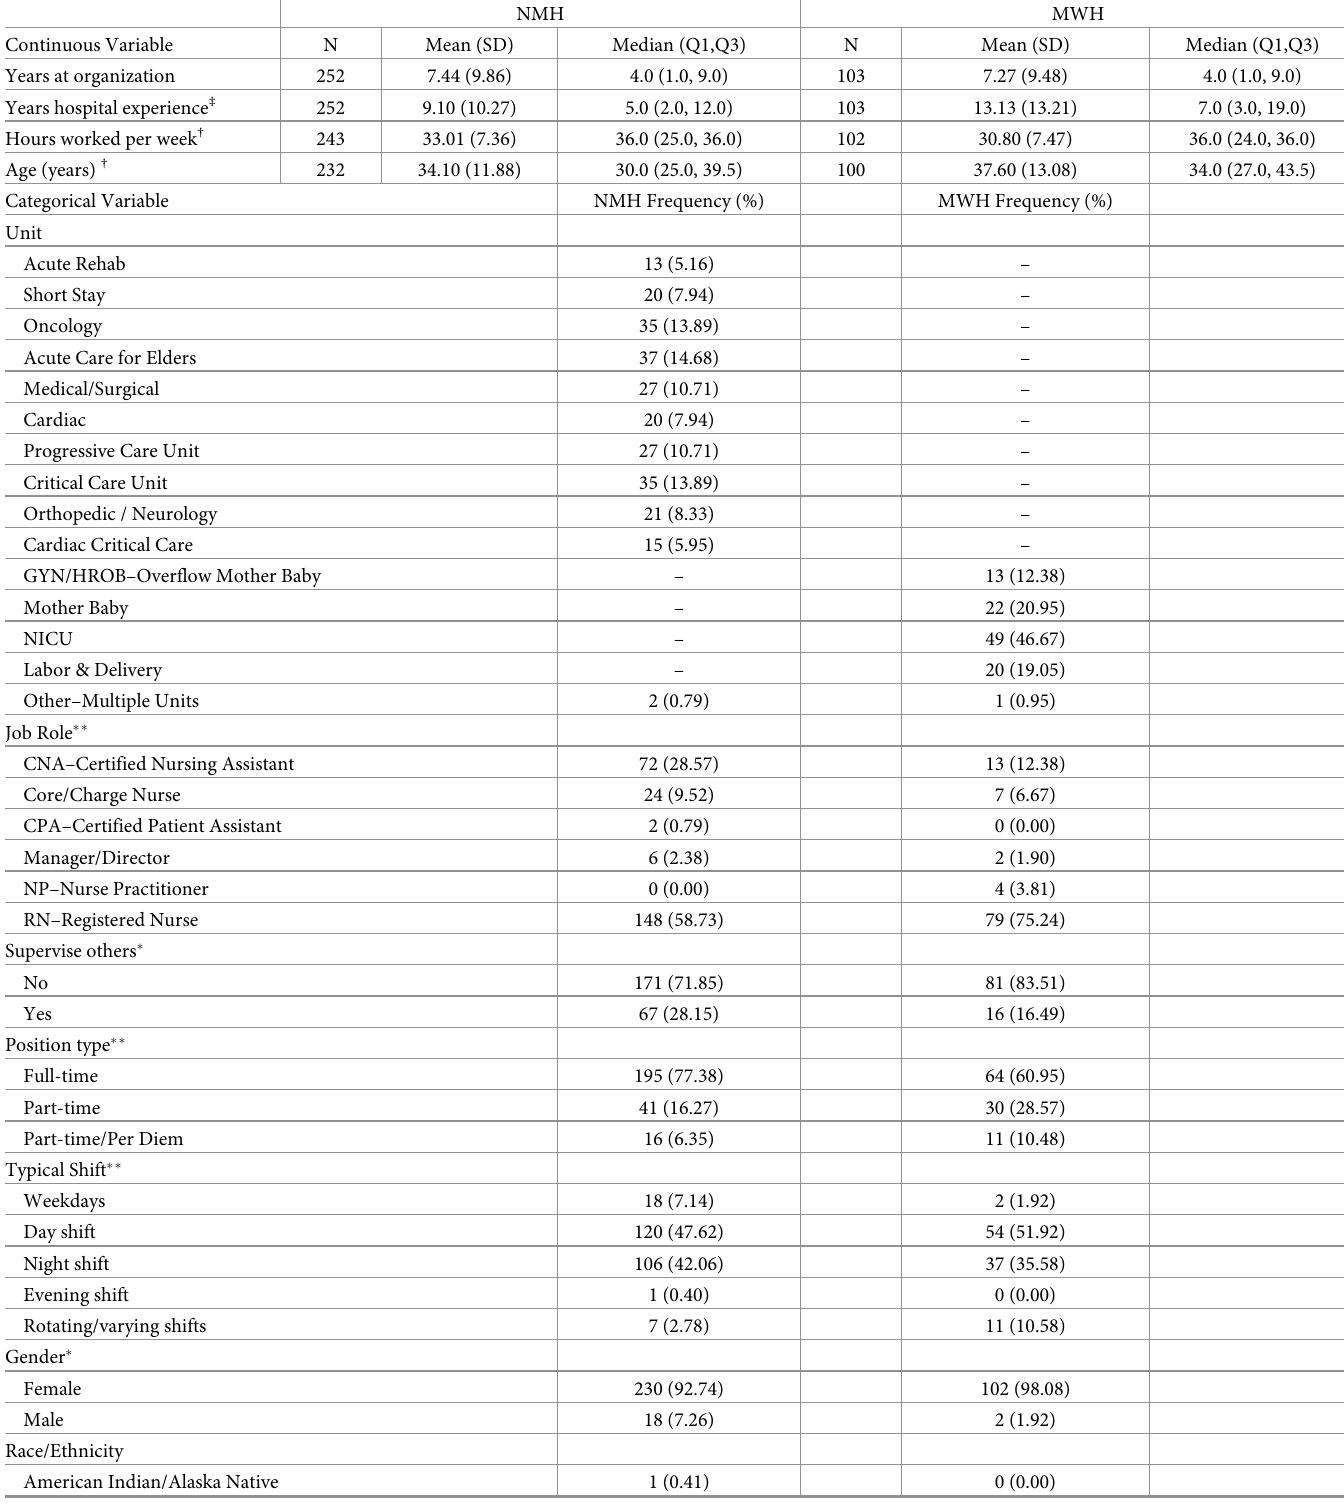
Table 9. Phase 4 participant demographics by